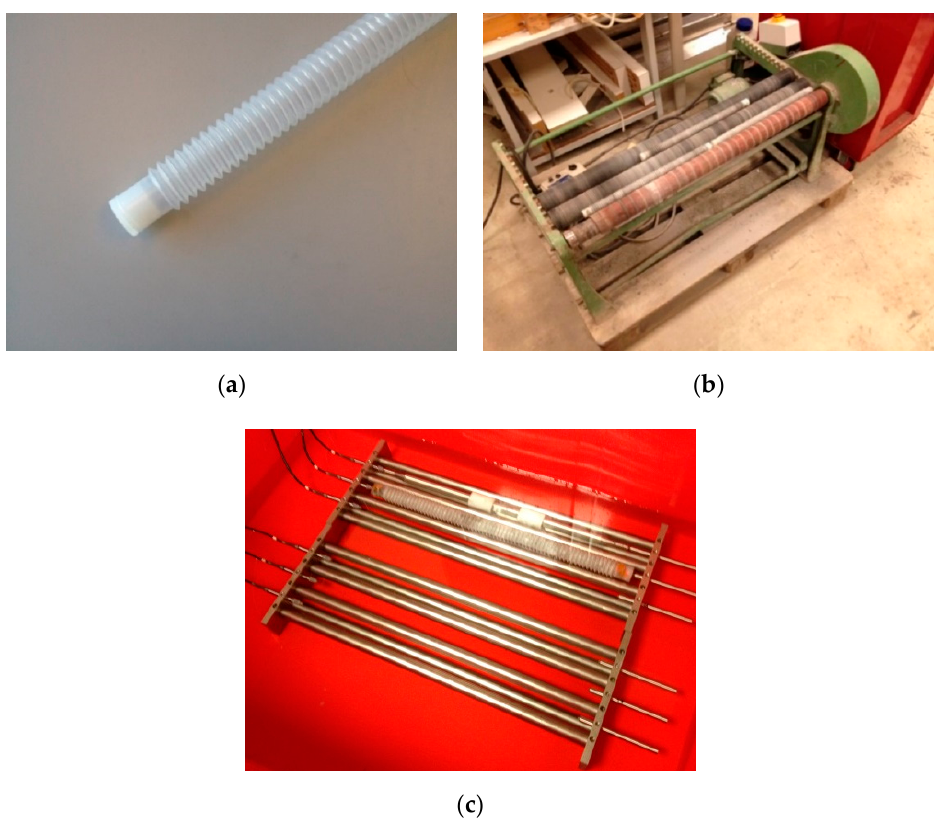
Figure 5. Setup for the autogenous shrinkage measurement; ( a ) Corrugated plastic tube; ( b ) Rotation machine; ( c ) Frame.